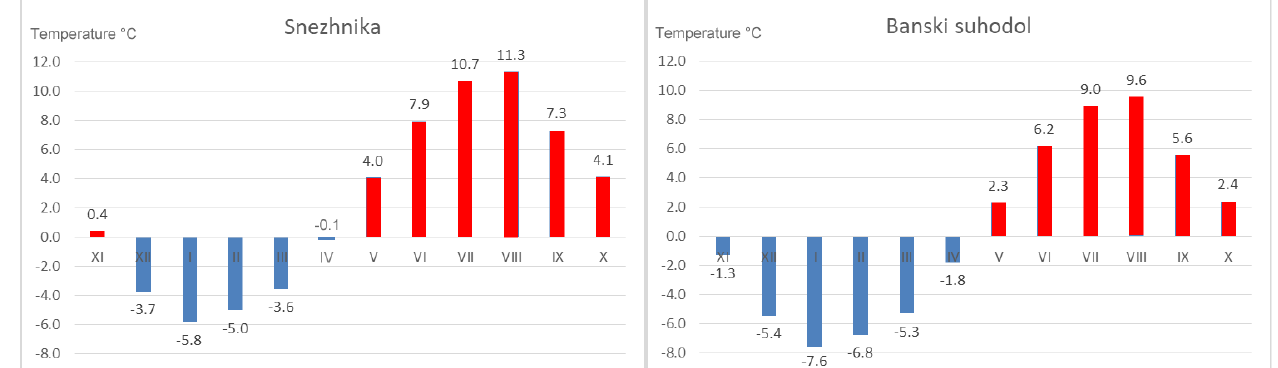
Figure 5. Average temperature conditions for the altitudes of Snezhnika and Banski suhodol glacierets, extrapolated from data from Musala peak for the period 2006–2021.